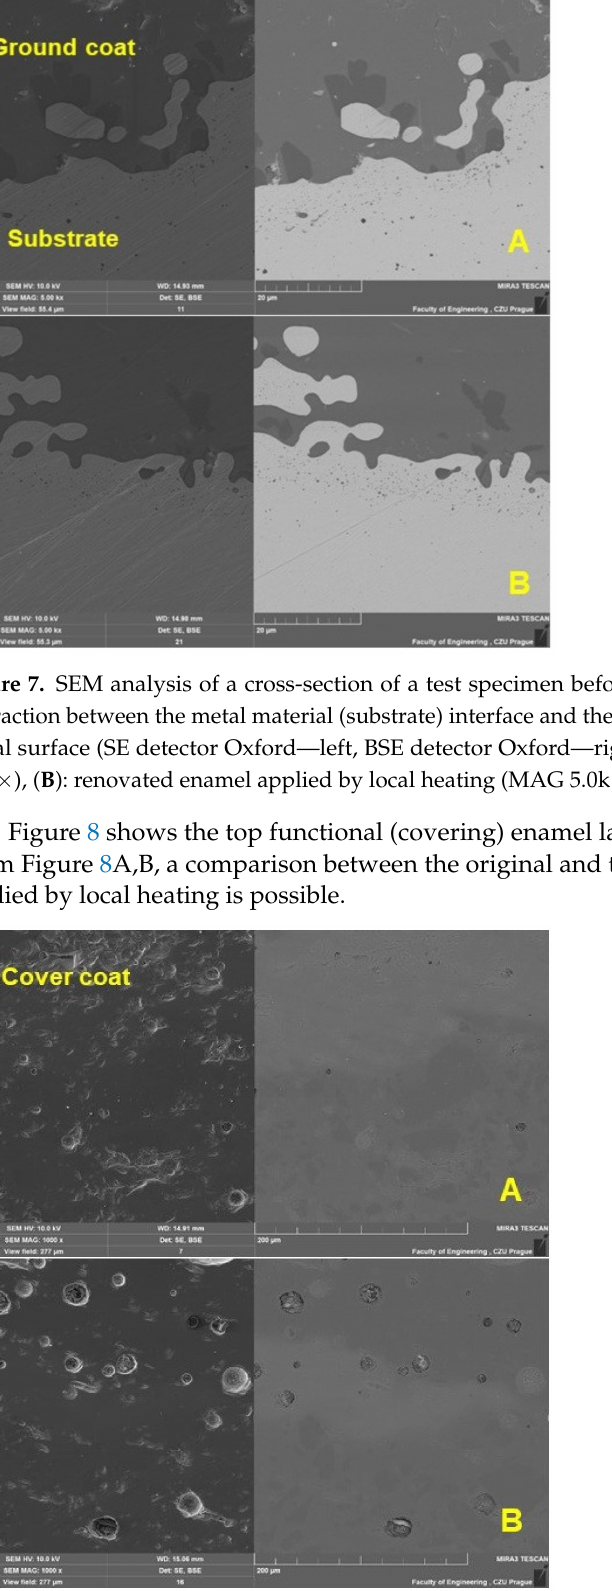
Figure 8. SEM analysis of the section of the test specimen before wear—a detailed view of the top (covering) enamel layer (SE Oxford detector—left, BSE Oxford detector—right): ( A ): original enamel (MAG 1.0k × ), ( B ): renovated enamel applied by local heating (MAG 1.0k ×